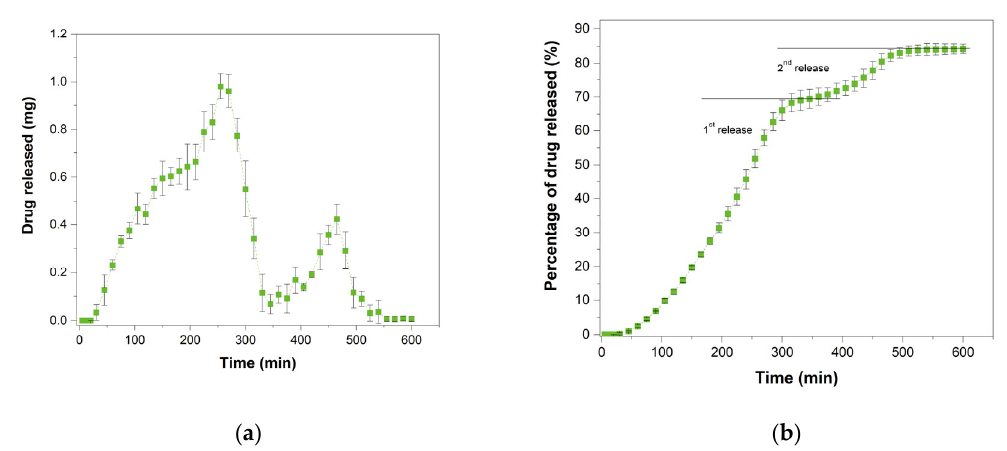
Figure 12. In vitro dissolution test of Pulsatile release tablets. ( a ) Shows the discrete release profile while ( b ) shows the cumulative release profiles obtained by addition of the data in the graph ( a ).